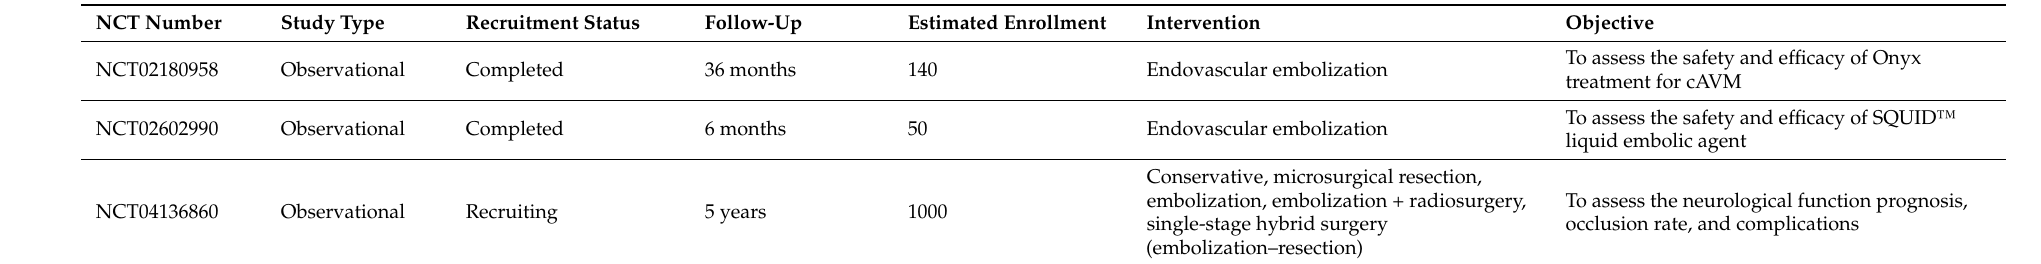
Table 3. The ongoing as well as completed clinical trials concerning the endovascular approach in the management of